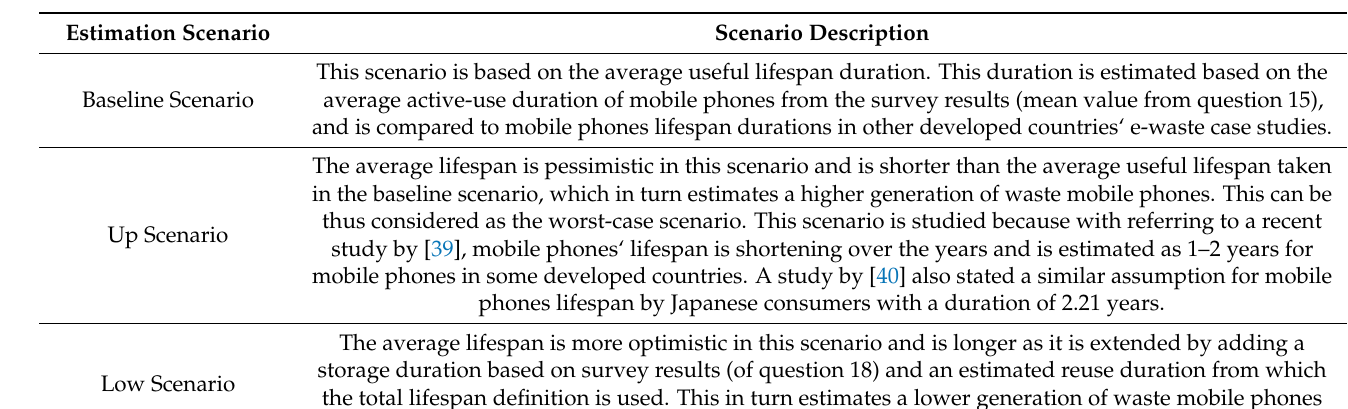
Table 5. Waste mobile phones estimation